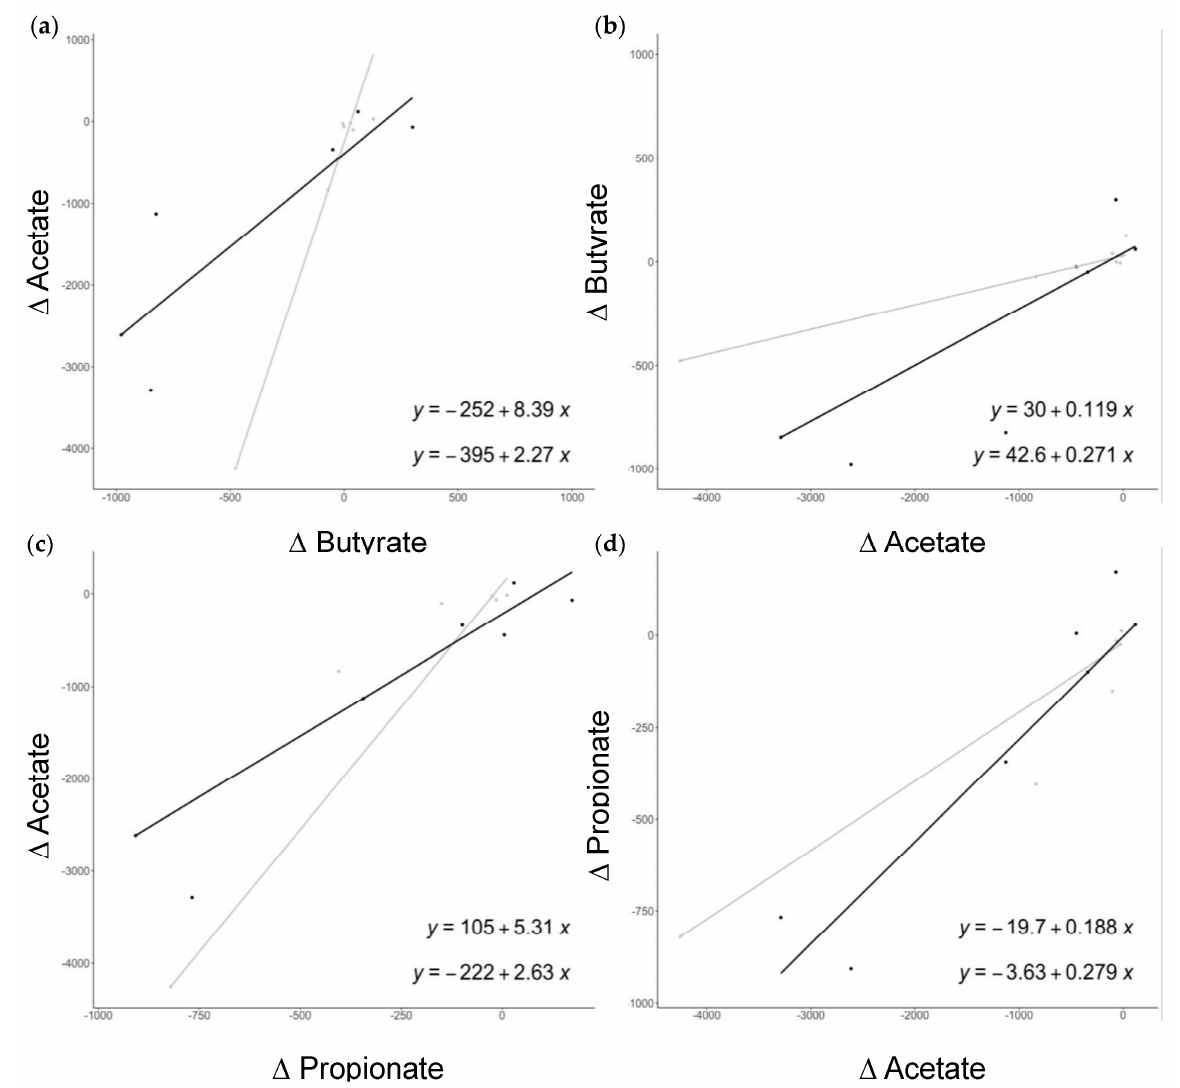
Figure 3. Associations among SCFAs in obese patients after PENS-Diet and PENS-Diet+Prob. The significant quantile regression models for differences (pre- and post-treatment) in ( a ) acetate vs. butyrate, ( b ) butyrate vs. acetate, ( c ) acetate vs. propionate, and ( d ) propionate vs. acetate. In the grey line, the PENS-Diet model. In the black line, PENS-Diet+Prob. The model equations for PENS-Diet (top) and PENS-Diet+Prob (bottom) are also shown.